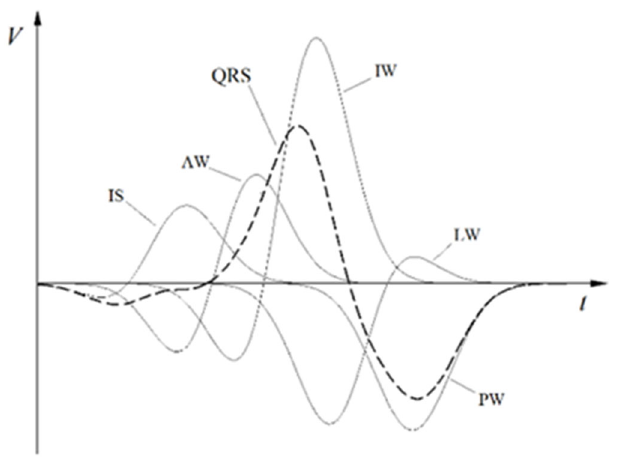
Figure 2. An example of the potential distribution for the Y coordinate (in the orthogonal Frank system related to the heart).